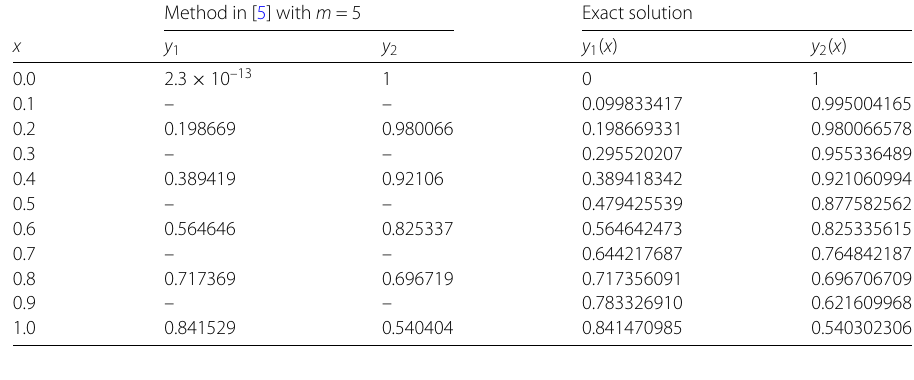
Table 3 Approximate solutions with m = 5 in [5] for Example 1